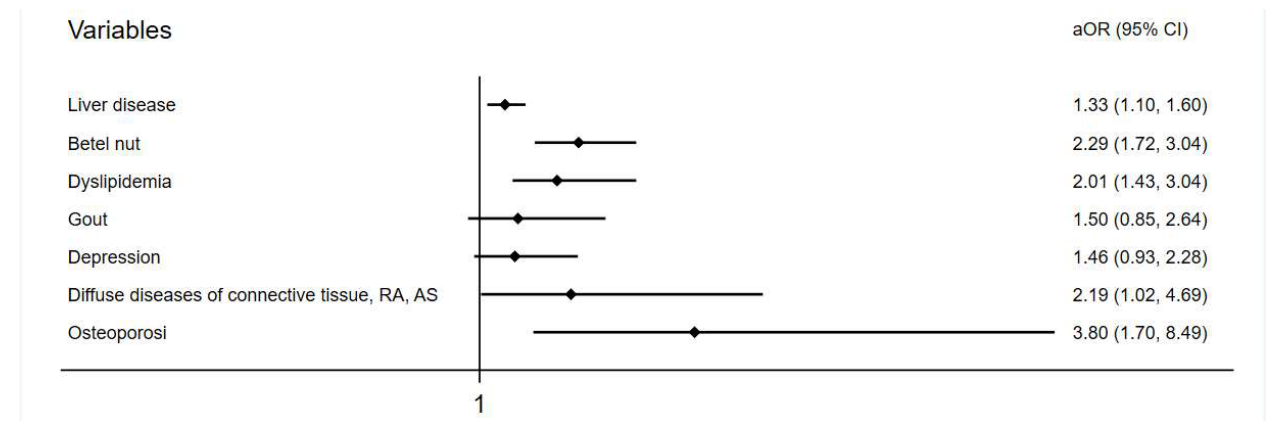
Figure 2. Adjusted odds ratio of variables in a forest plot. Table 1. Demographic characteristics at baseline.